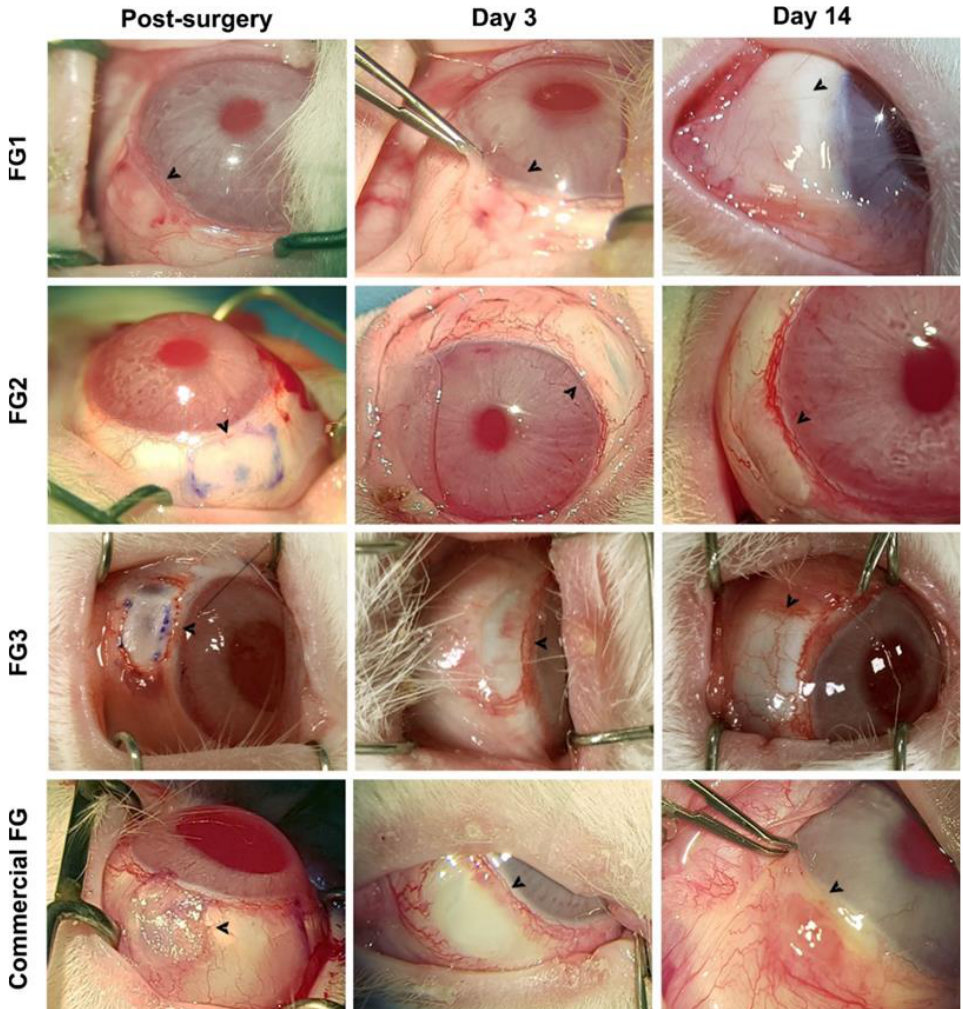
Figure 4. Clinical evolution of bulbar conjunctiva autografts on a bare scleral bed transplanted using different FGs and the commercial FG. Arrows show the grafted area in the bulbar conjunctiva. FG: bio-based fibrin